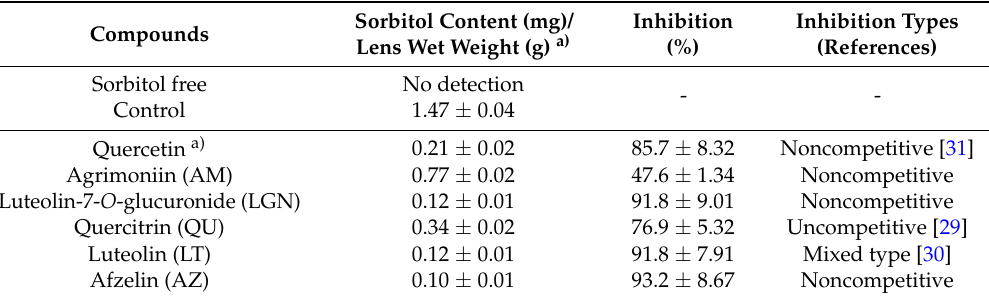
Figure 3. HPLC-ultraviolet (UV) (before reaction: blue) and DPPH-HPLC-UV (after reaction: red) of the n -BuOH fraction from A. pilosa Ledeb. at 254 nm ( A ) and quantitative reduction (%) in the peak areas of compounds designated as follows ( B ); Peak 1: Agrimoniin; Peak 2: Rutin; Peak 3: Luteolin-7- O -glucoside; Peak 4: Luteolin-7- O -glucuronide; Peak 5: Quercitrin; Peak 6: Apigenin-7- O -glucoside; Peak 7: Apigenin-7- O -glucuronide; * is DPPH. Table 3. Inhibitory effect of the constituents on the sorbitol accumulation in rat lenses and inhibition type by active